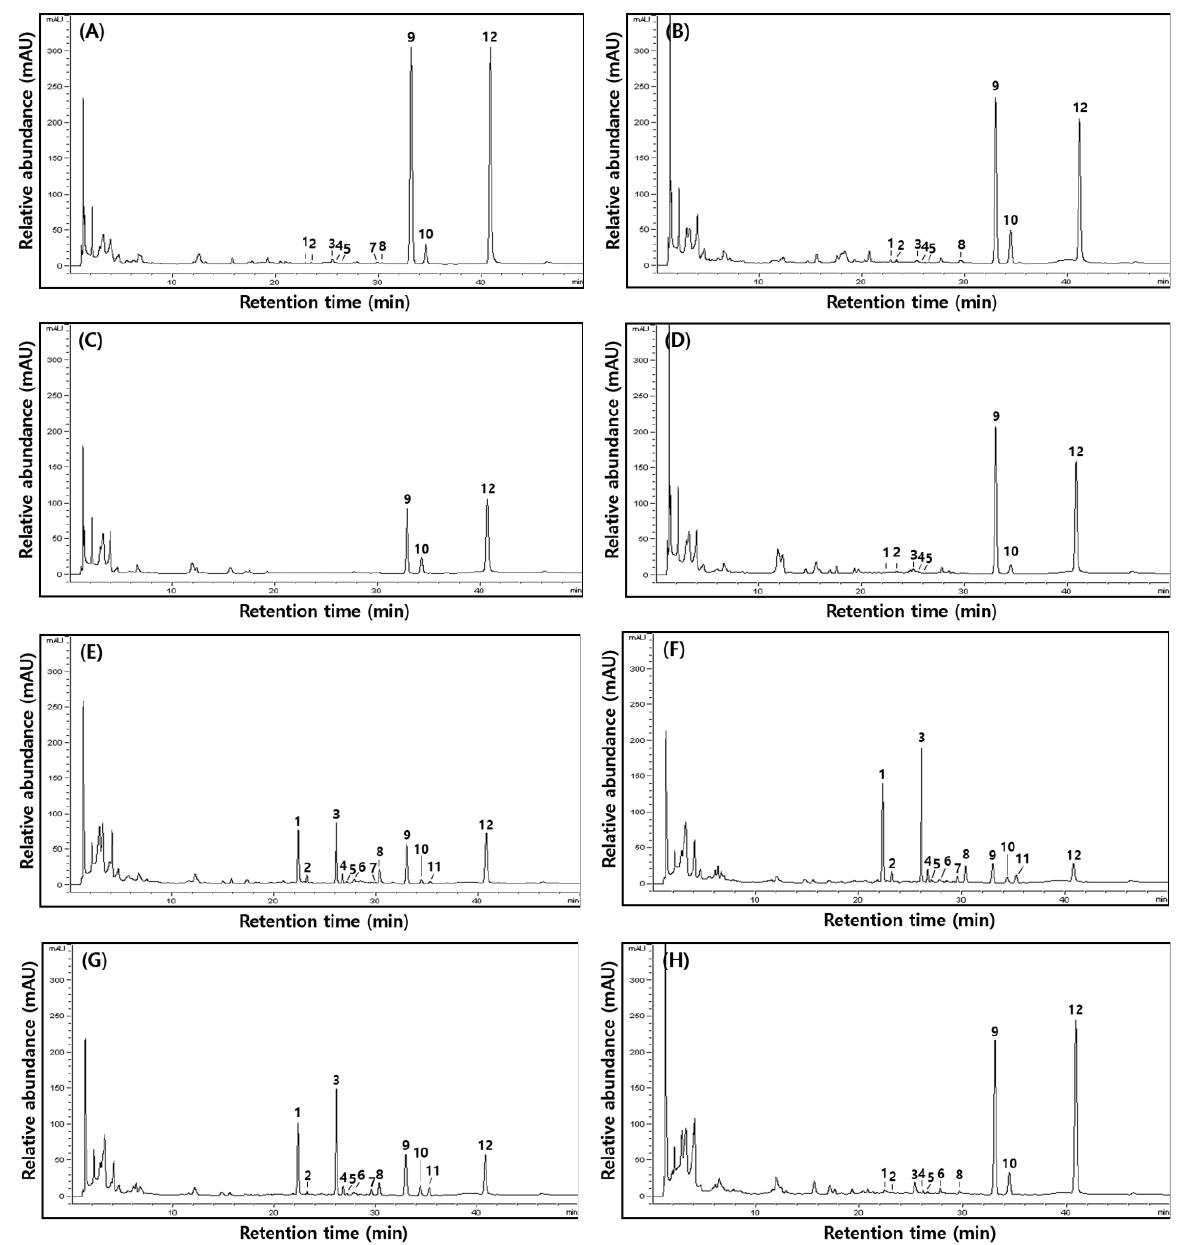
Figure 5. Representative HPL chromatograms of 50% MeOH extracts from household ( A ) 1HDJ, ( B ) 2HDJ, ( C ) 3HDJ, and ( D ) 4HDJ and commercial ( E ) 1CDJ, ( F ) 2CDJ, ( G ) 3CDJ, and ( H ) 4 CDJ. Peaks assignment with 1, 2, 3, 4, 5, 6, 7, 8, 9, 10, 11, and 12 are marked as daidzin, glycitin, genistin, malonyldaidzin, malonylglycitin, acetyldaidzin, acetylglycitin, malonylgenistin, daidzein, glycitein, acetylgenistin, and genistein, respectively.